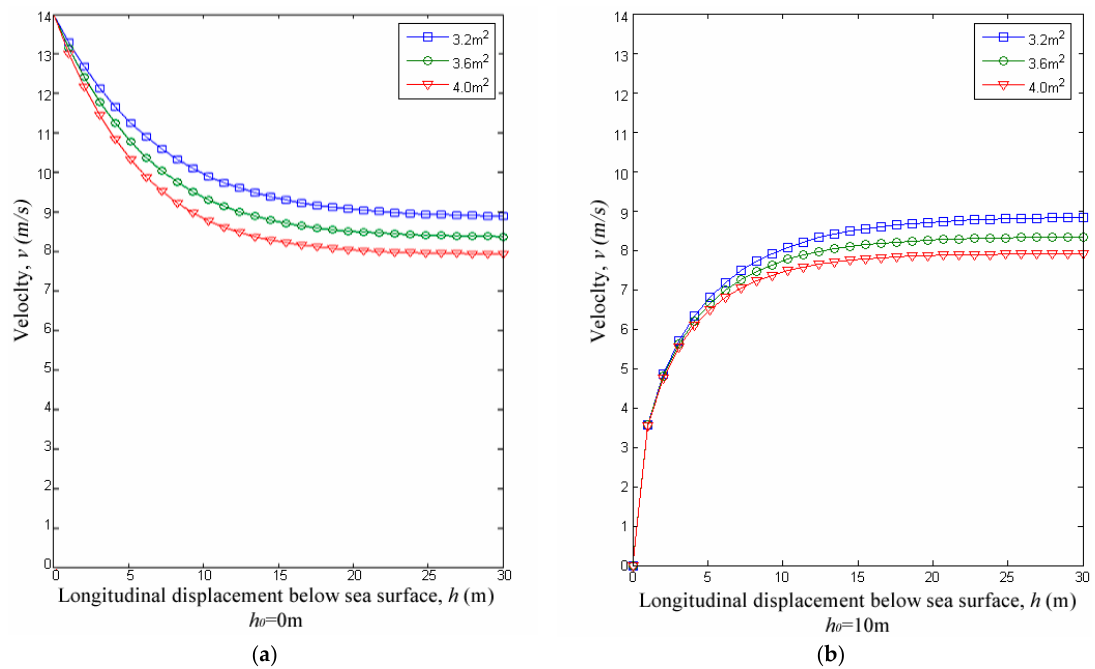
Figure 5. Falling speeds of anchors with different horizontal plane projected areas (( a ) at altitudes of 0 and ( b ) at altitudes of 10 m).